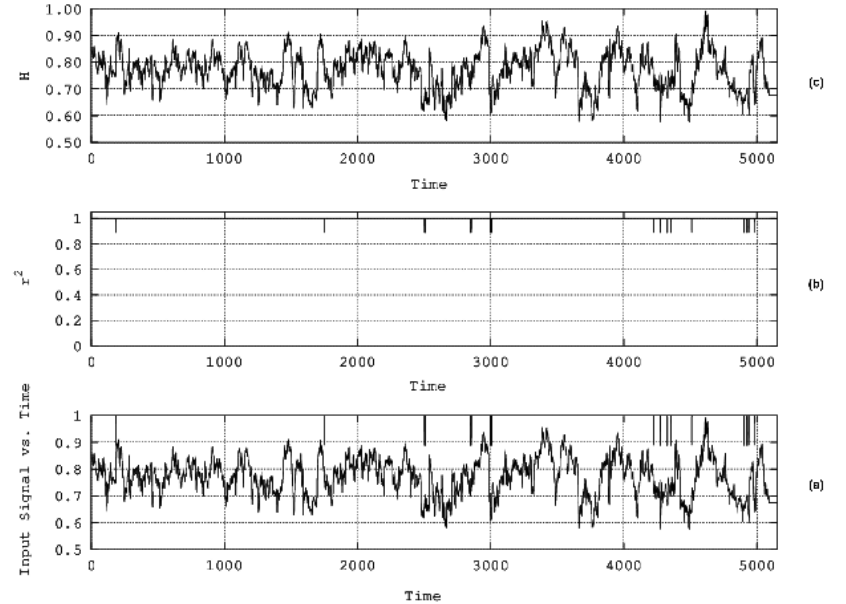
Figure 5. R/S analysis of the PM 10 time series recorded by the AGP station between the years 2001–2016. From bottom to top: ( a ) time series (mean daily values/concentrations). ( b ) Square of Spearman’s correlation coefficient. ( c ) Hurst exponent time series. PM 10 concentration in µ g/m 3 . Time is in days (or sample number). Each window of analysis contains 64